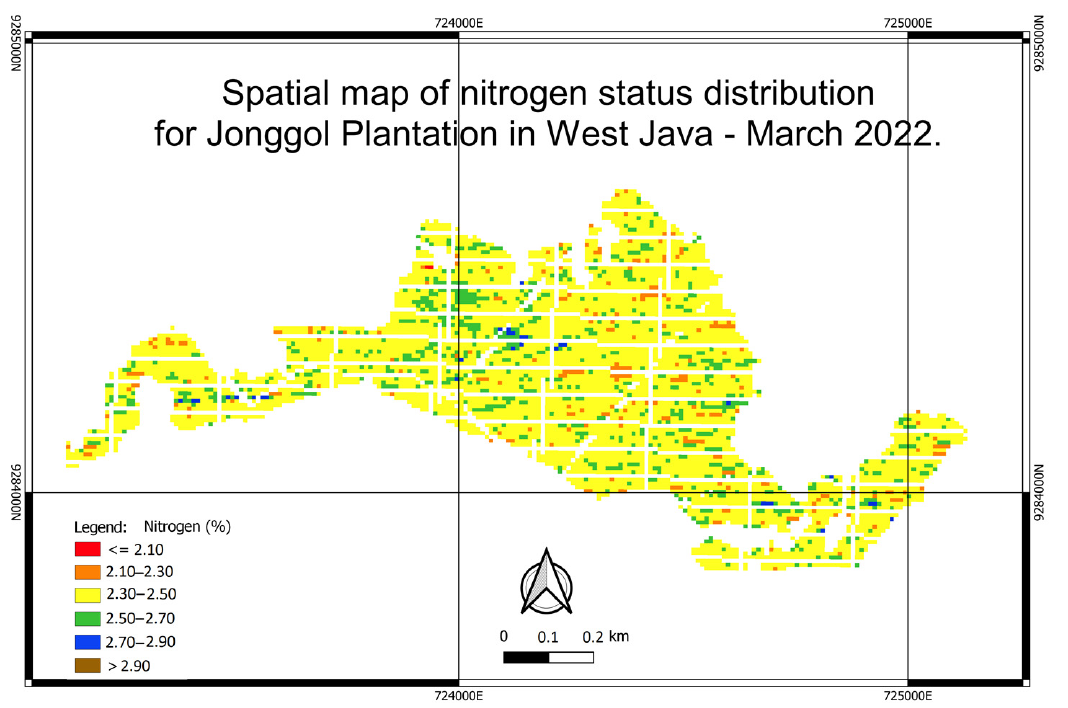
Figure 10. Spatial Map of nitrogen status distribution for Jonggol plantation in West Java March 2022.